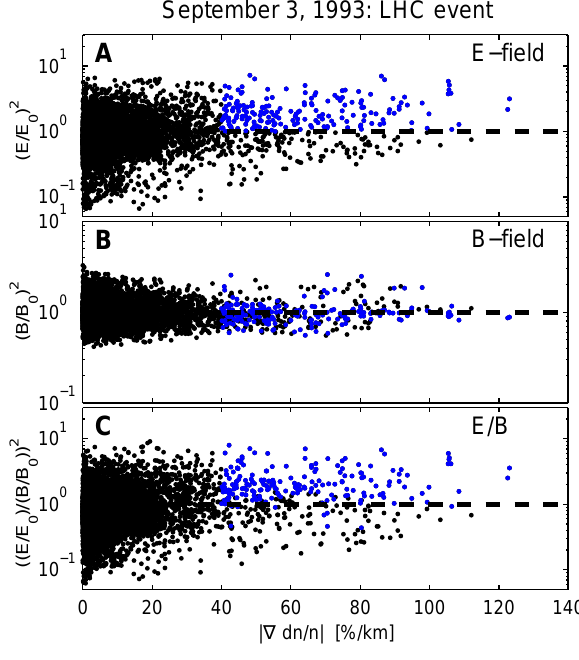
Fig. 4. Variations of the wave power for an irregular density variation case. The analysis is based on 10s of data from 28 July 1994, containing the three gradients presented in Fig. 3. Panels (A) and (B) show variations in the electric and magnetic wave power versus the gradient of the density, |∇ dn/n | . The wave power is normalized to the average wave power over the surrounding 0.5s. Hence, a ratio larger than one means that there is an enhancement in the wave power. For steep gradients ( |∇ dn/n | & 30%/km) we see clear enhancements of both the electric and the magnetic wave power. Panel (C) presents the variation in E/B versus |∇ dn/n | .